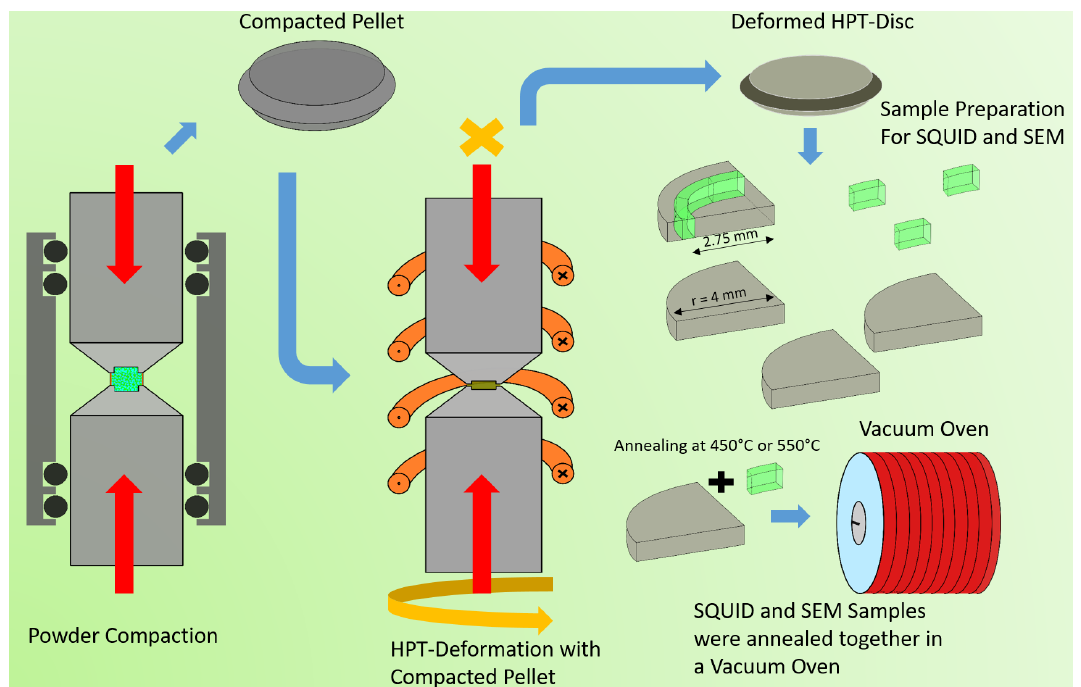
Figure A1. Schematic description of the sample synthesis. From left to right: Powder blends were compacted with HPT inside an airtight capsule. The obtained pellet was used for HPT-deformation experiments. An inductive heating system provided the needed processes temperature for the HPT- anvils. HPT-disc was cut into the desired size for further investigations. The SQUID samples were cut out at the desired radius. For the annealing experiments a HPT-disc was cut into quarters. One quarter provided the SQUID-samples, which were cut out at the same radius. The SQUID sample was simultaneously annealed with a quarter of the